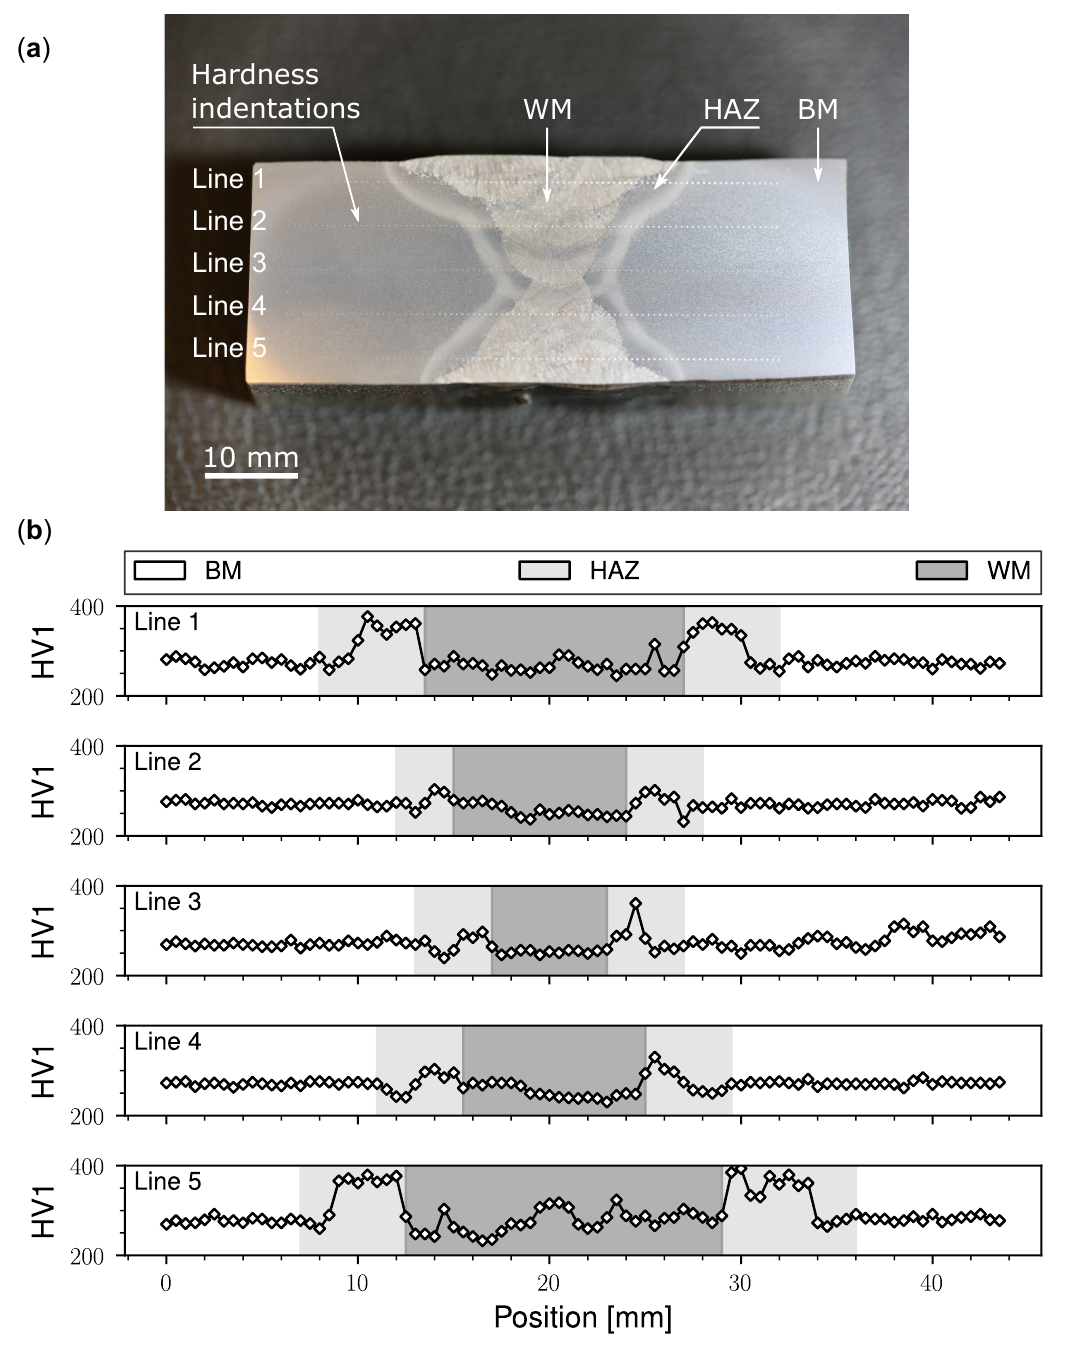
Figure 1. Macro sample of the welded S690 steel with micro hardness indentations: ( a ) annotated macro sample, ( b ) corresponding hardness